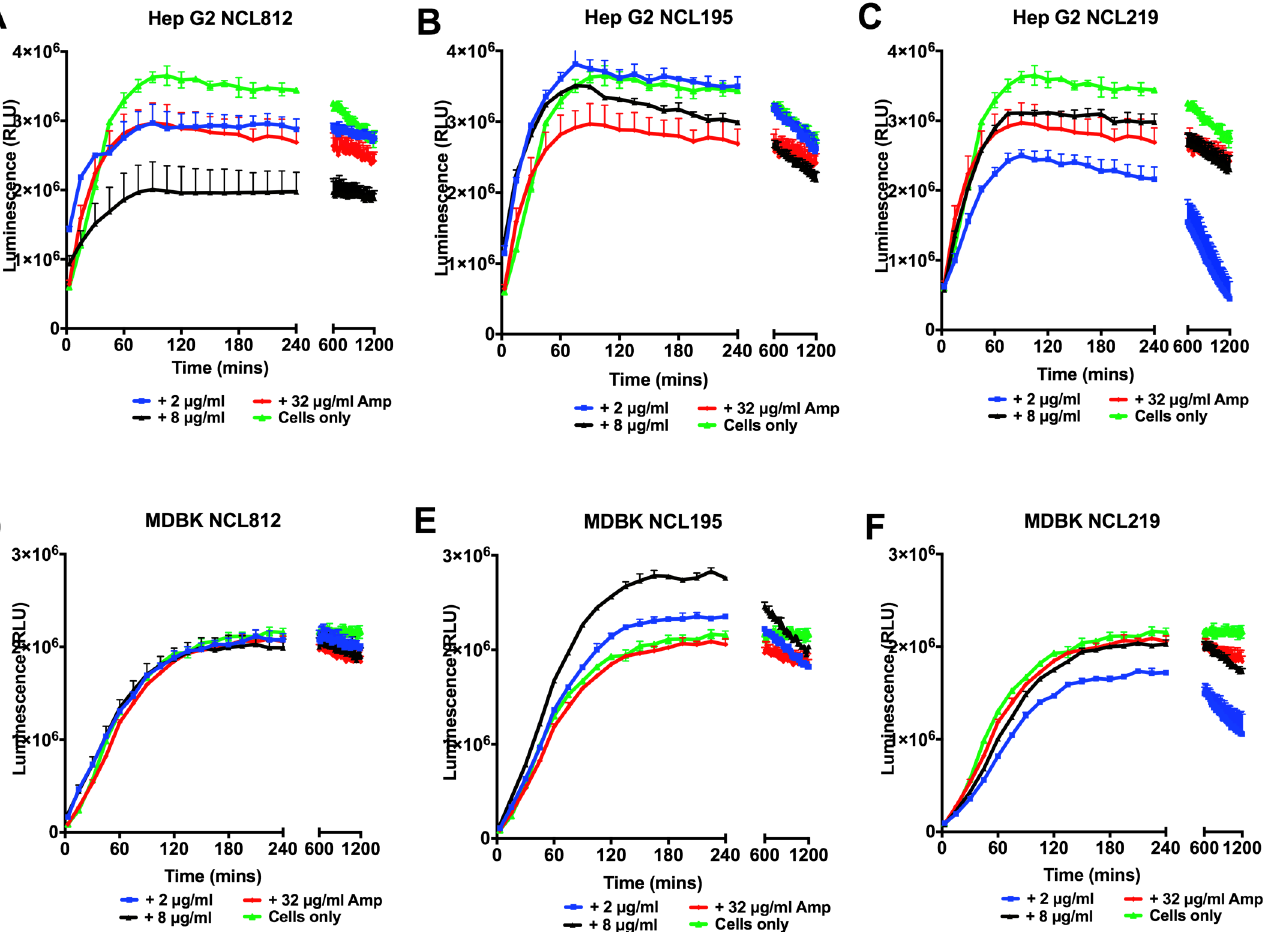
Fig 5. NCL195 demonstrates limited cytotoxicity to mammalian cell lines. Real-timecell viabilitymeasurements for Hep G2 ( A, B, C ) and MDBK ( D, E, F ) cells after treatment with 2 or 8 μ g/ml NCL812, NCL195or NCL219.Cell viabilitywas measured every 60 min for 20 h at 37˚C and 5% CO 2 on a Cytation 5 Cell Imaging Multi-Mode Reader(BioTek) using the RealTime-Glo MT Cell Viability Assay reagent (Promega). Data are means ( ± s.e.m.) relative light units (RLU) for each treatment per time point (in